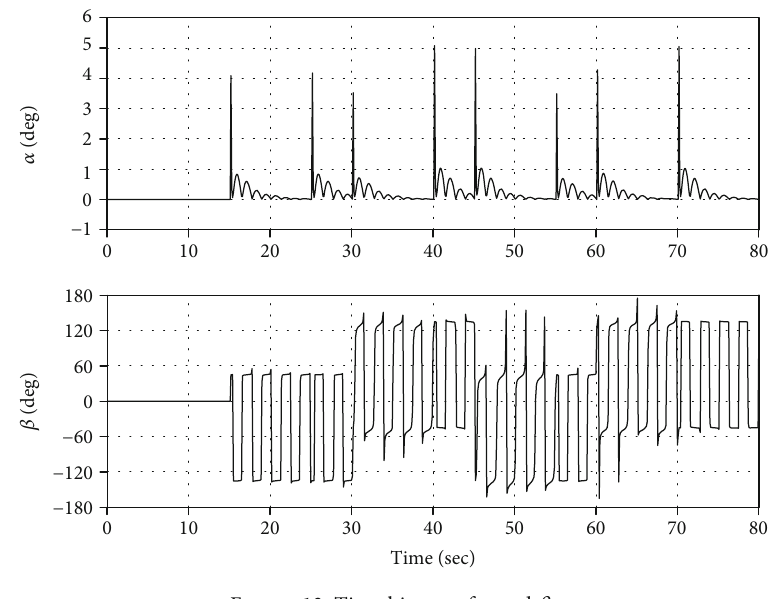
Figure 13: Time history of α and β .